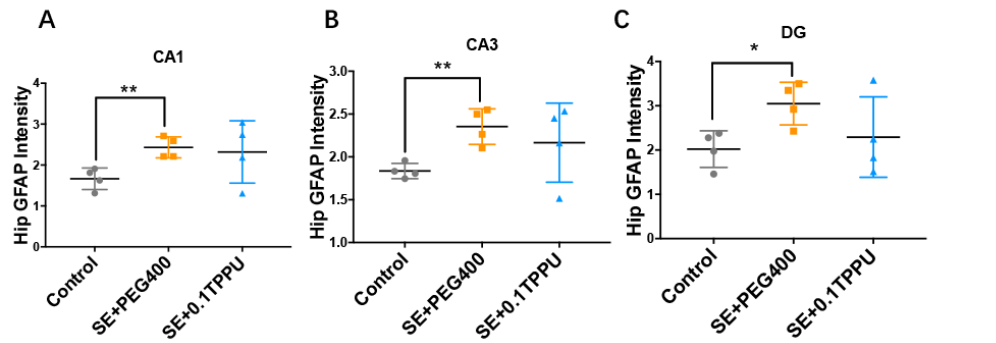
Figure 4. The fluorescence intensity of GFAP in CA1 subarea ( A ), CA3 subarea ( B ), and DG subarea ( C ) was significantly increased in SE+PEG400 group compared with Control group (Figure 4A–C , one-way ANOVA test, n = 4 in every group, * p < 0.05, ** p < 0.01). CA, Cornu Ammonis; DG, dentate gyrus; Hip, hippocampus. GFAP, glial fibrillary acidic protein. The levels of pro-inflammatory cytokines in the hippocampus of rats were deter- mined by the ELISA method. The results showed that the levels of pro-inflammatory cy- tokines including IL-1 β , IL-6, and TNF- α were significantly increased in the hippocampus of the SE+PEG400 group compared with the Control group, and the level of IL-1 β was solely significantly attenuated in the hippocampus of SE+0.1TPPU group compared with the SE+PEG400 group (Figure 5A–C, n = 4 in every group, * p < 0.05, ** p < 0.01).